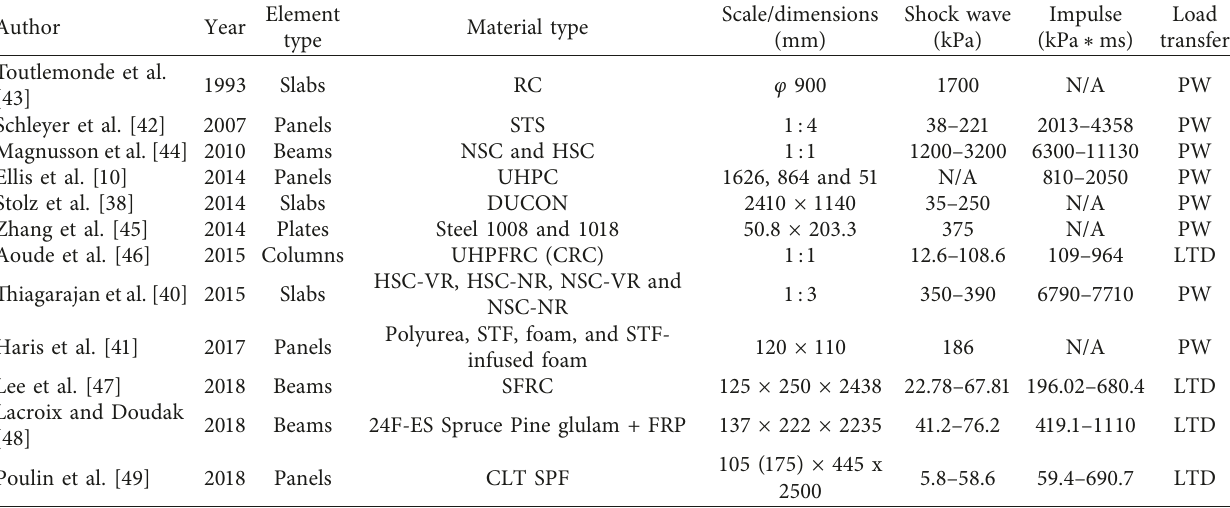
Table 2: Shock tube